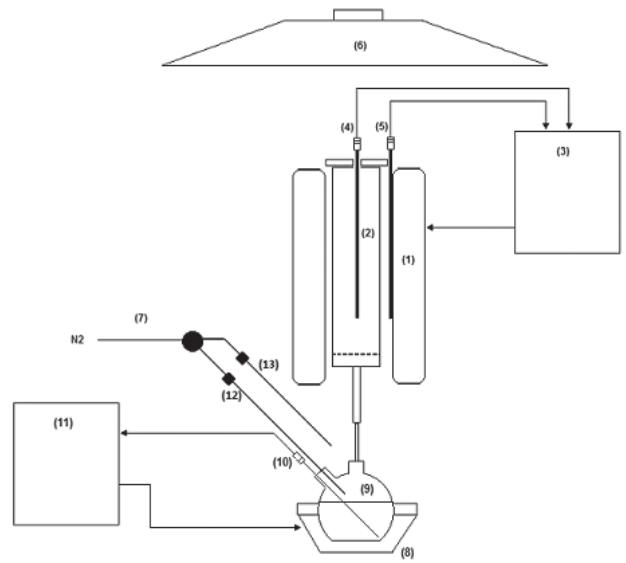
Figure 1 - Apparatus for carbonization and activation of jute fibers.